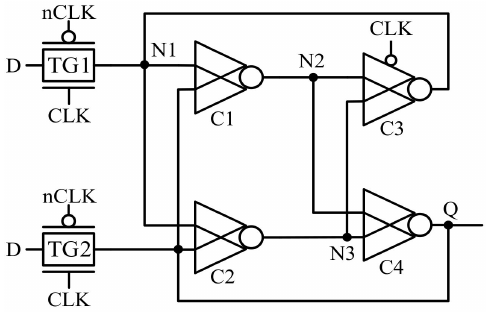
Figure 3. Schematic of HRPU